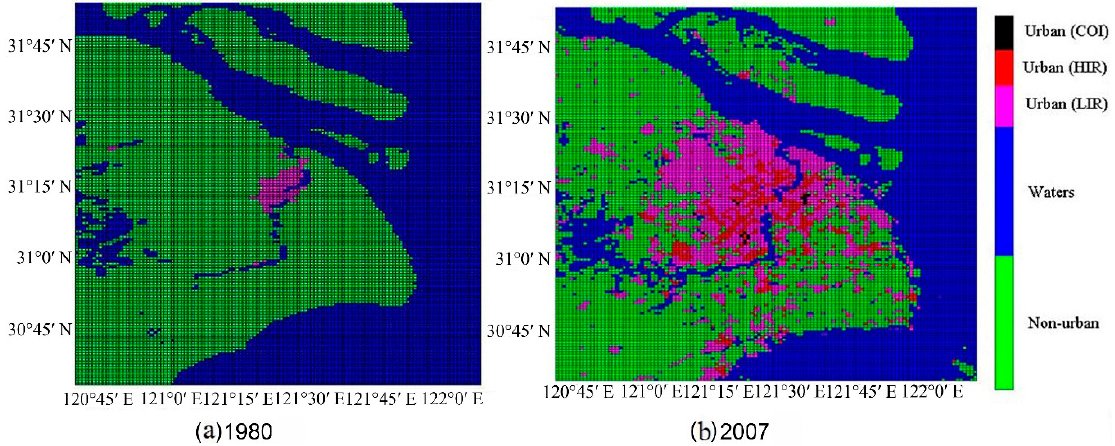
Figure 2. The land use of Shanghai in ( a ) 1980 and ( b ) 2007. Table 1. Urban morphological parameters considered for the three urban classes: commercial or industrial (COI), high-intensity residential (HIR), and low-intensity residential (LIR).